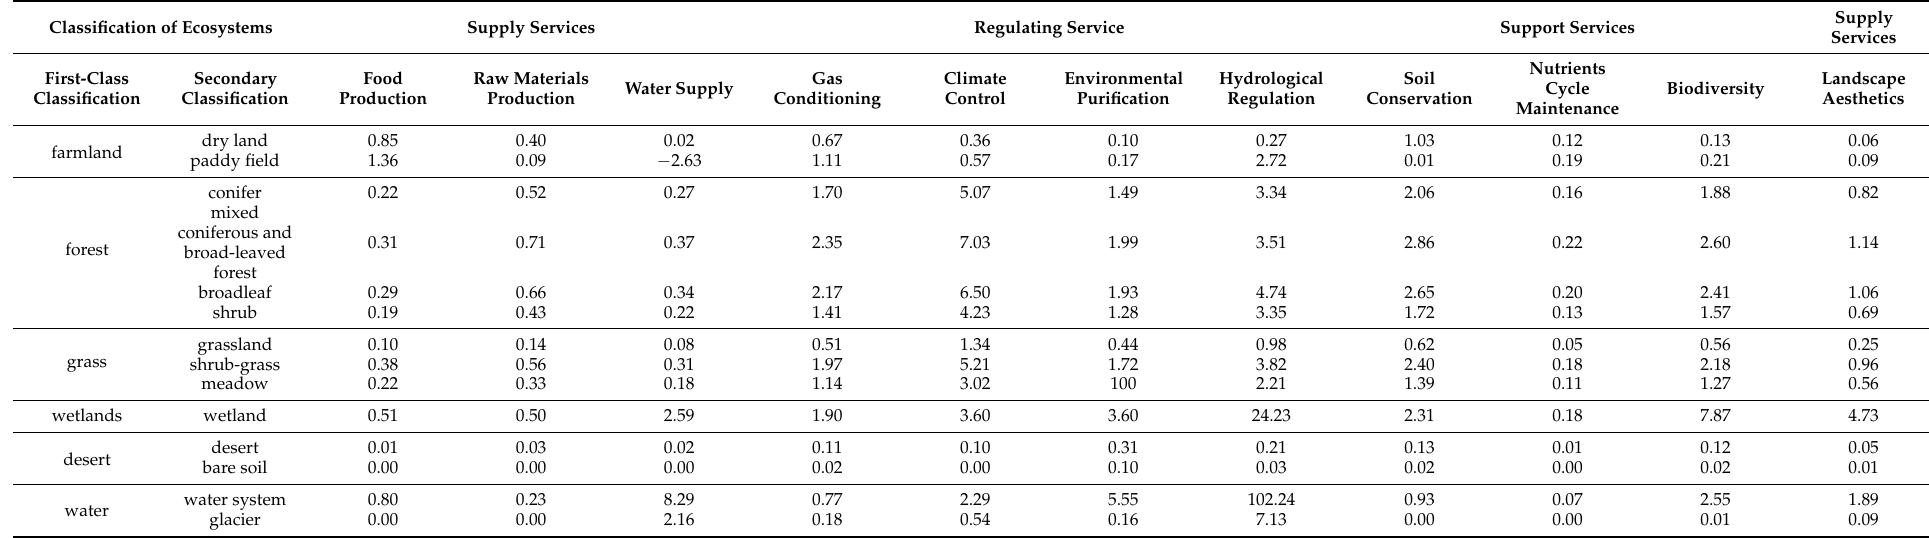
Table 4. Table of ecosystem service value equivalent per unit